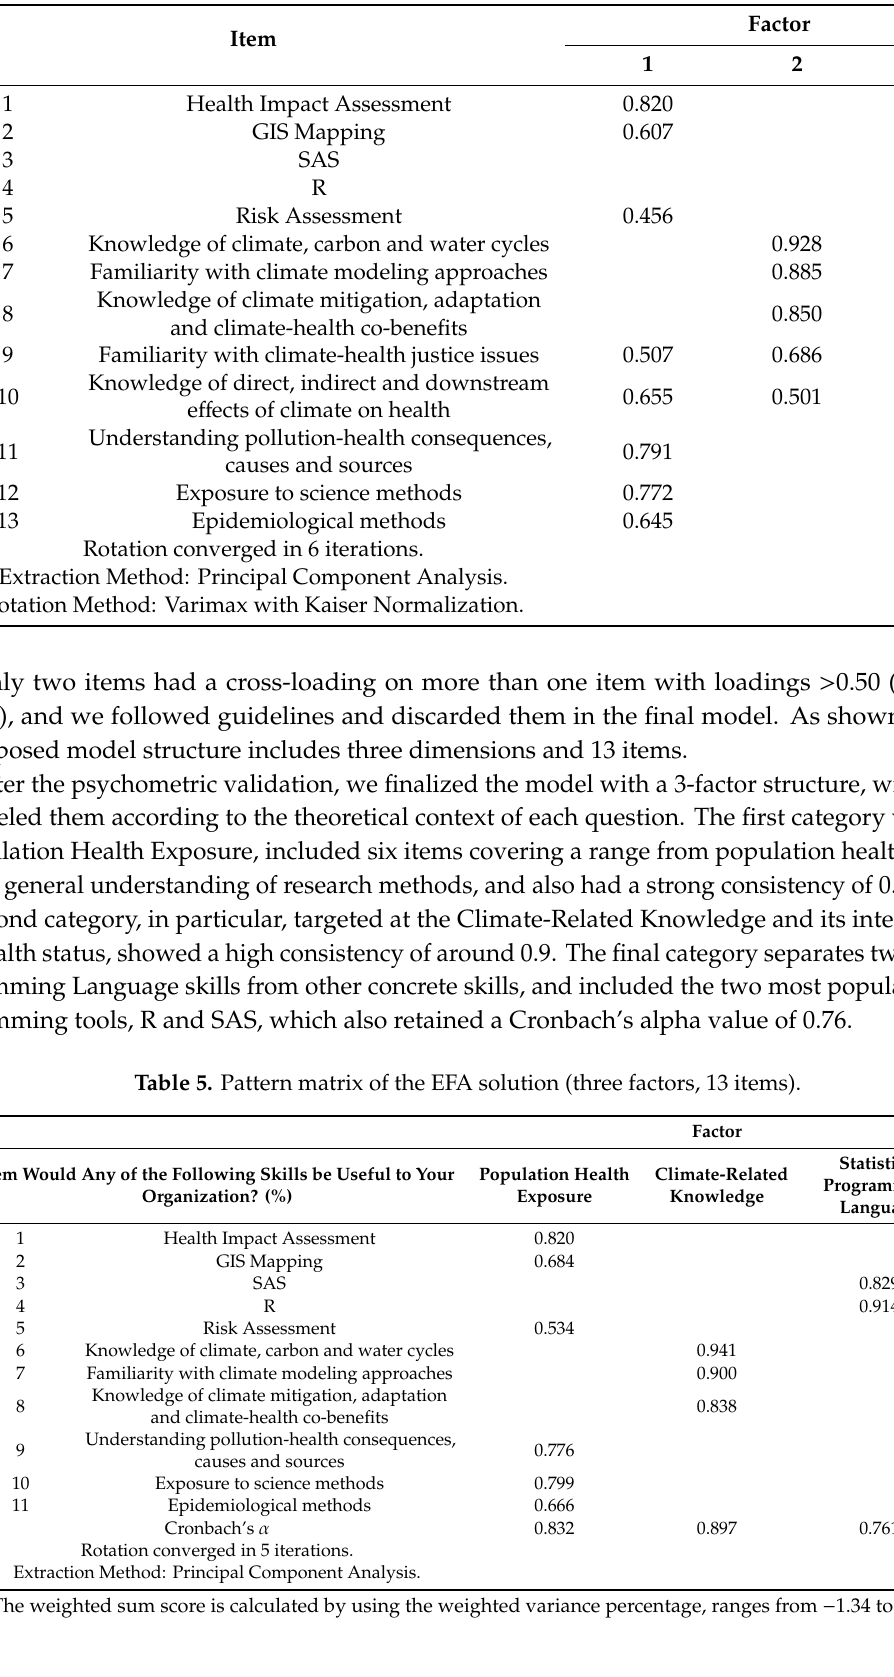
Table 4. Pattern matrix of the EFA solution (three factors, 13 items).